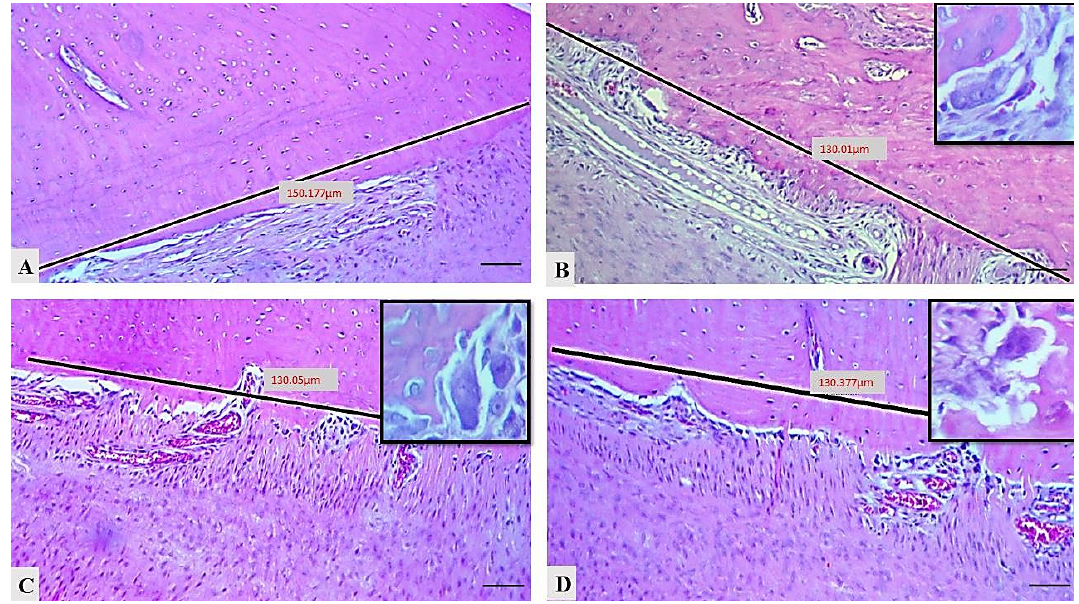
Figure 4. Histometric counting of osteoclasts (insets showed multinucleated, ruffle border osteoclasts) in diverse groups: ( A ) control negative group, ( B ) control positive group, ( C ) treatment control group, ( D ) EOK treatment group, (H&E, scale bar 20 μm).